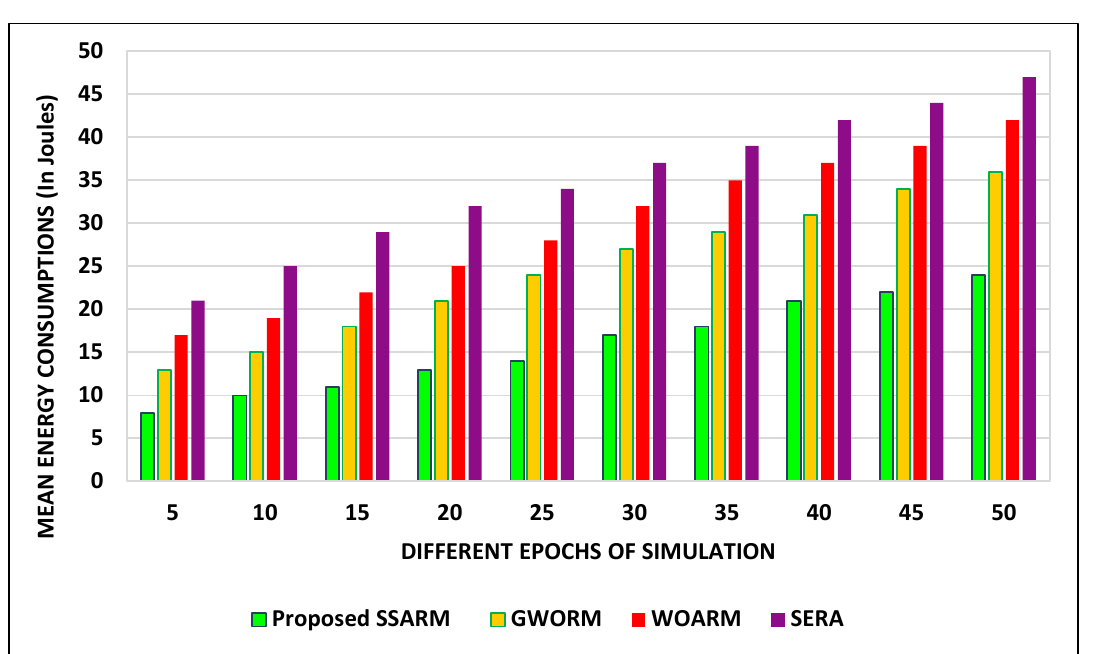
Figure 7. Proposed SSARM-Mean Energy Consumptions with Different Epochs of Simulation